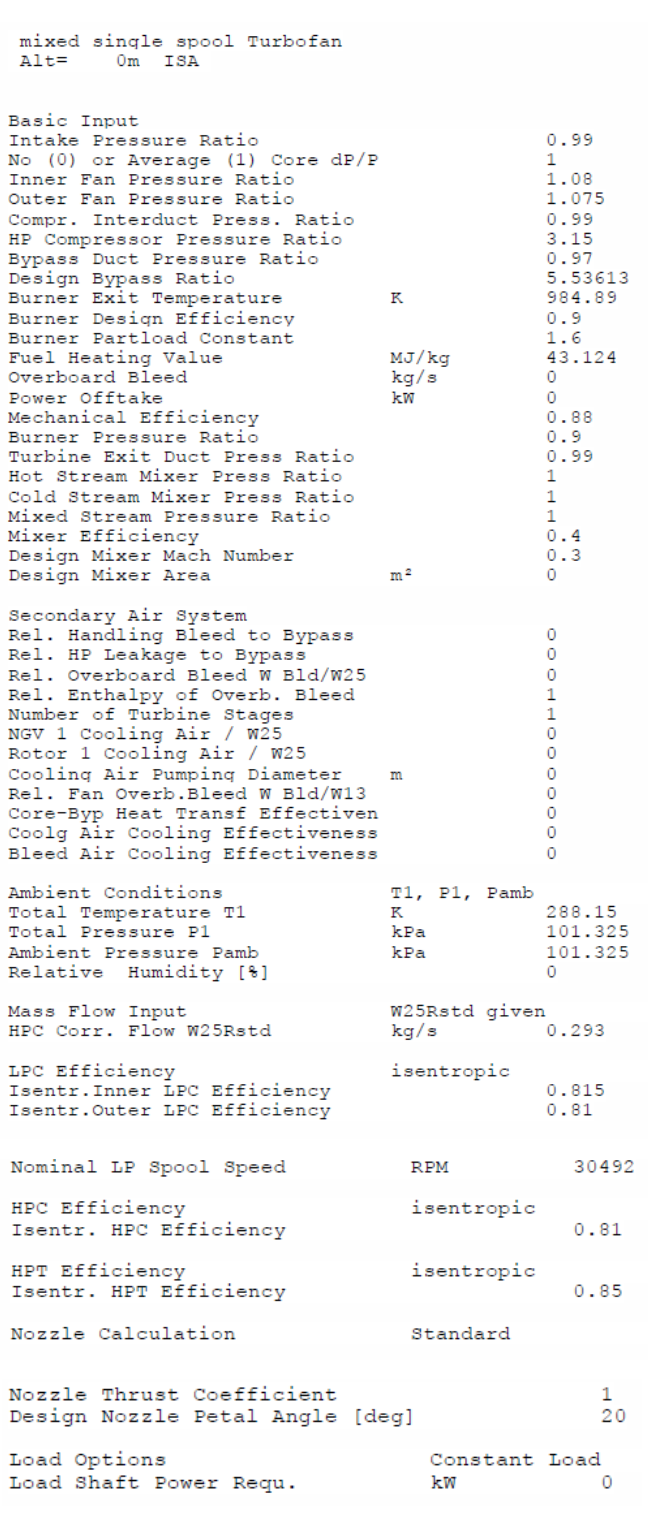
Figure A2. Basic input parameters for the micro turbojet GasTurb engine model.